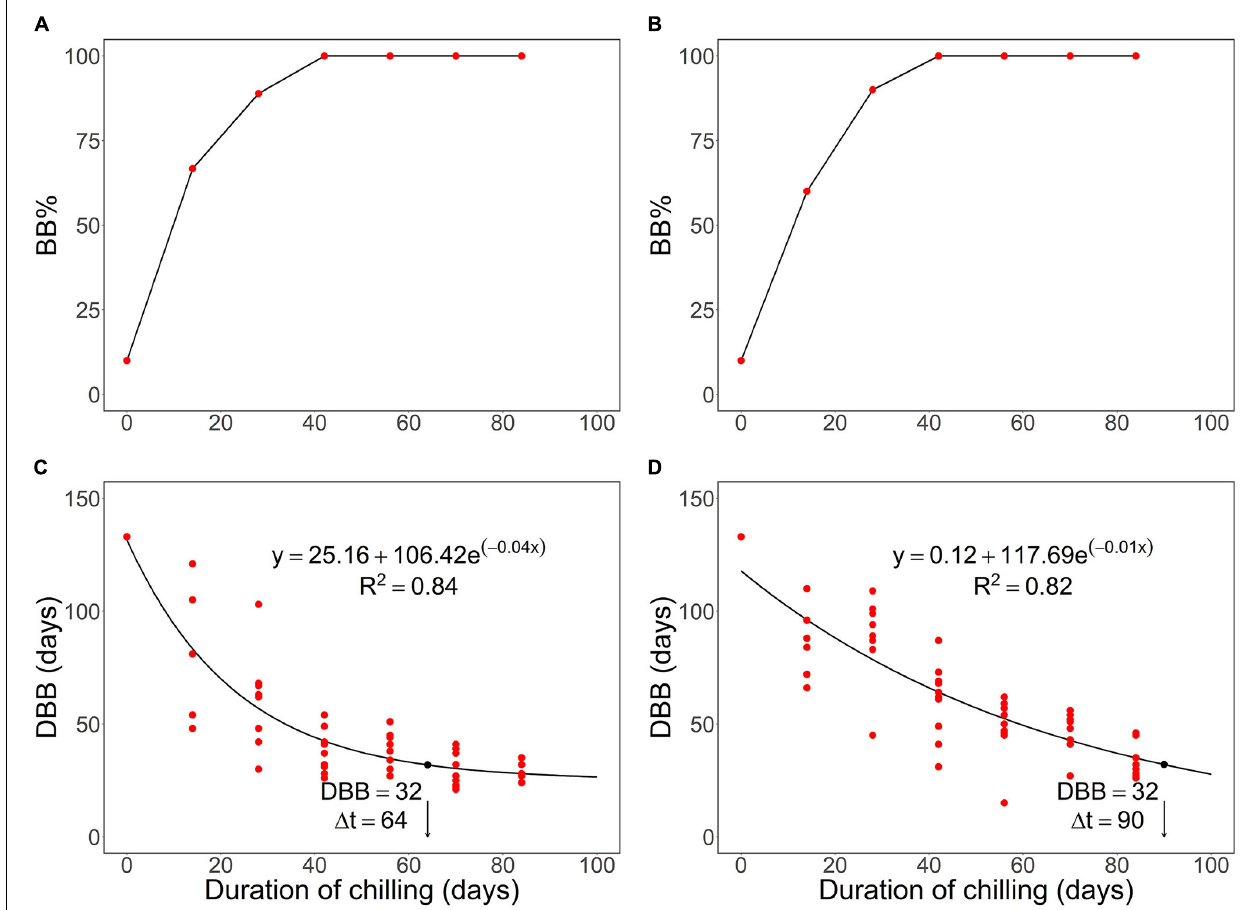
FIGURE 1 | Effects of chilling on a rest break in first-year pecan seedlings in the autumn experiment, where both controlled chilling in constant +6 ◦ C (A,C) and chilling outdoors under natural conditions (B,D) were used. The rest break caused by prolonged chilling is manifested after the transfer to the growth-promoting forcing conditions as an increase in panels (A,B) bud burst percentage, BB% and a decrease in panels (C,D) days to bud burst (DBB). The arrow and the index (cid:49) t indicate the estimated number of days required for meeting the chilling requirement of rest completion under the chilling conditions. The black dot indicates the corresponding value of the DBB at the time of rest completion. Note that the phenological event observed was leaf-out but that the concept “bud burst” is used here as a generic one facilitating the use of the standard indices BB% and